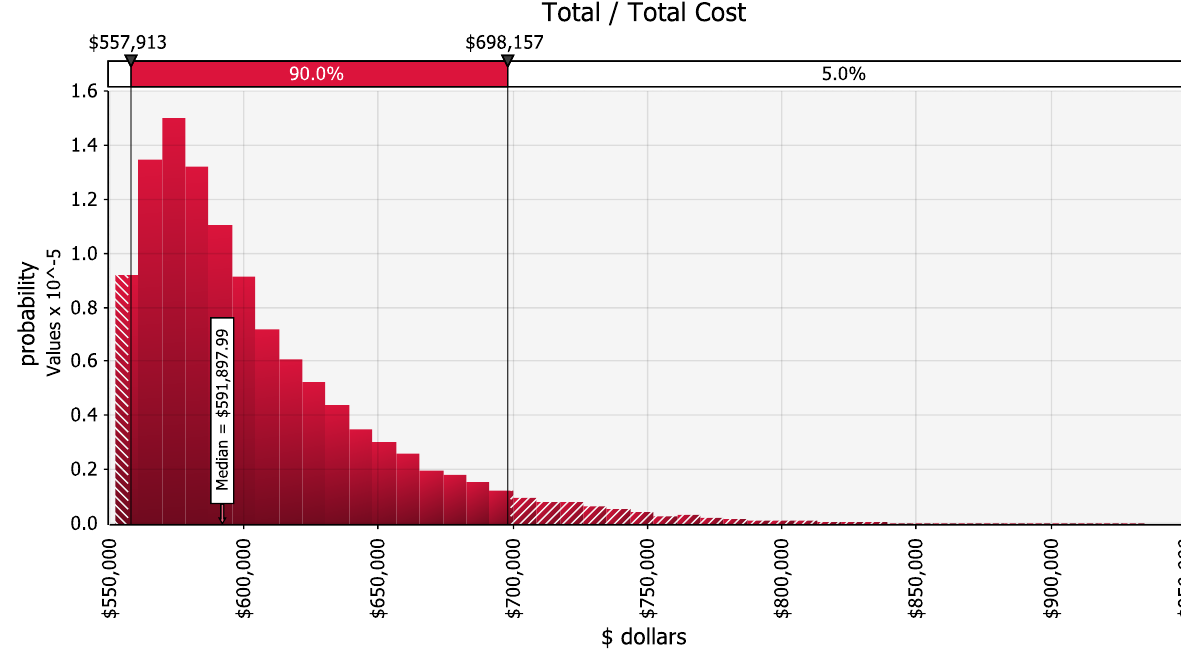
Figure 6. Total project cost ($ dollars) probability distribution. Source [37].